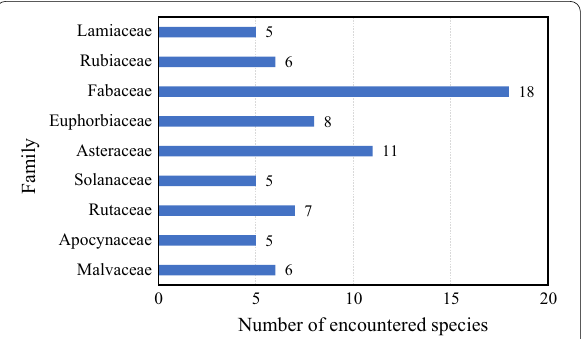
Fig. 3 Different methods used in the preparation of anticancer remedies from medicinal plants in